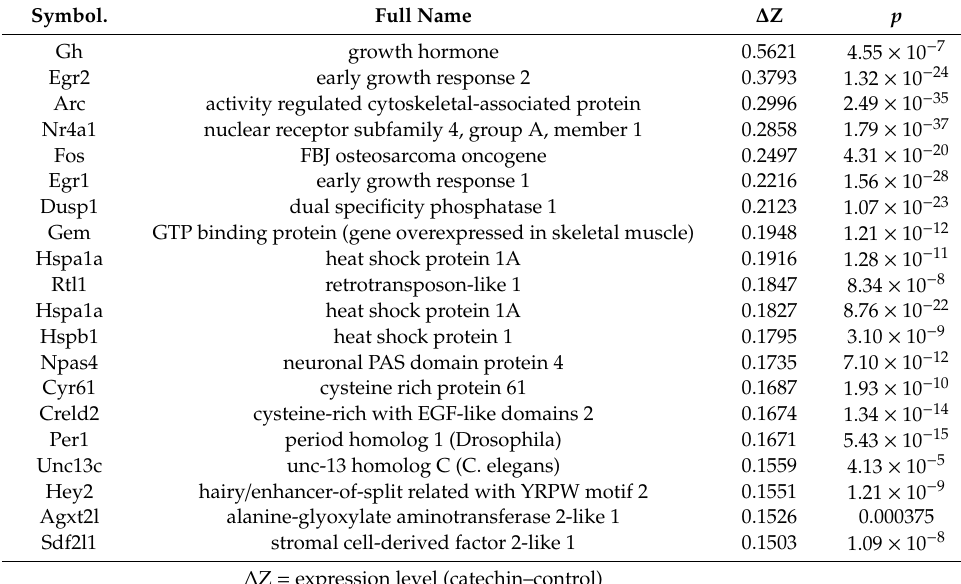
Table 3. Upregulated genes in hippocampi of mice that ingested GT-catechin (60 mg / kg): top 20. Symbol.